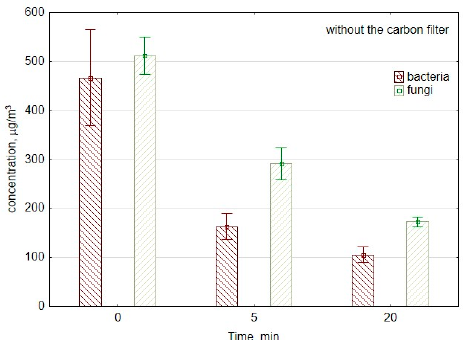
Figure 3. The concentration of bacterial and fungal aerosols during the work of air purifier consisting of mesh filter and ozone generator. The data represent the average values and the standard deviations of six measurements.